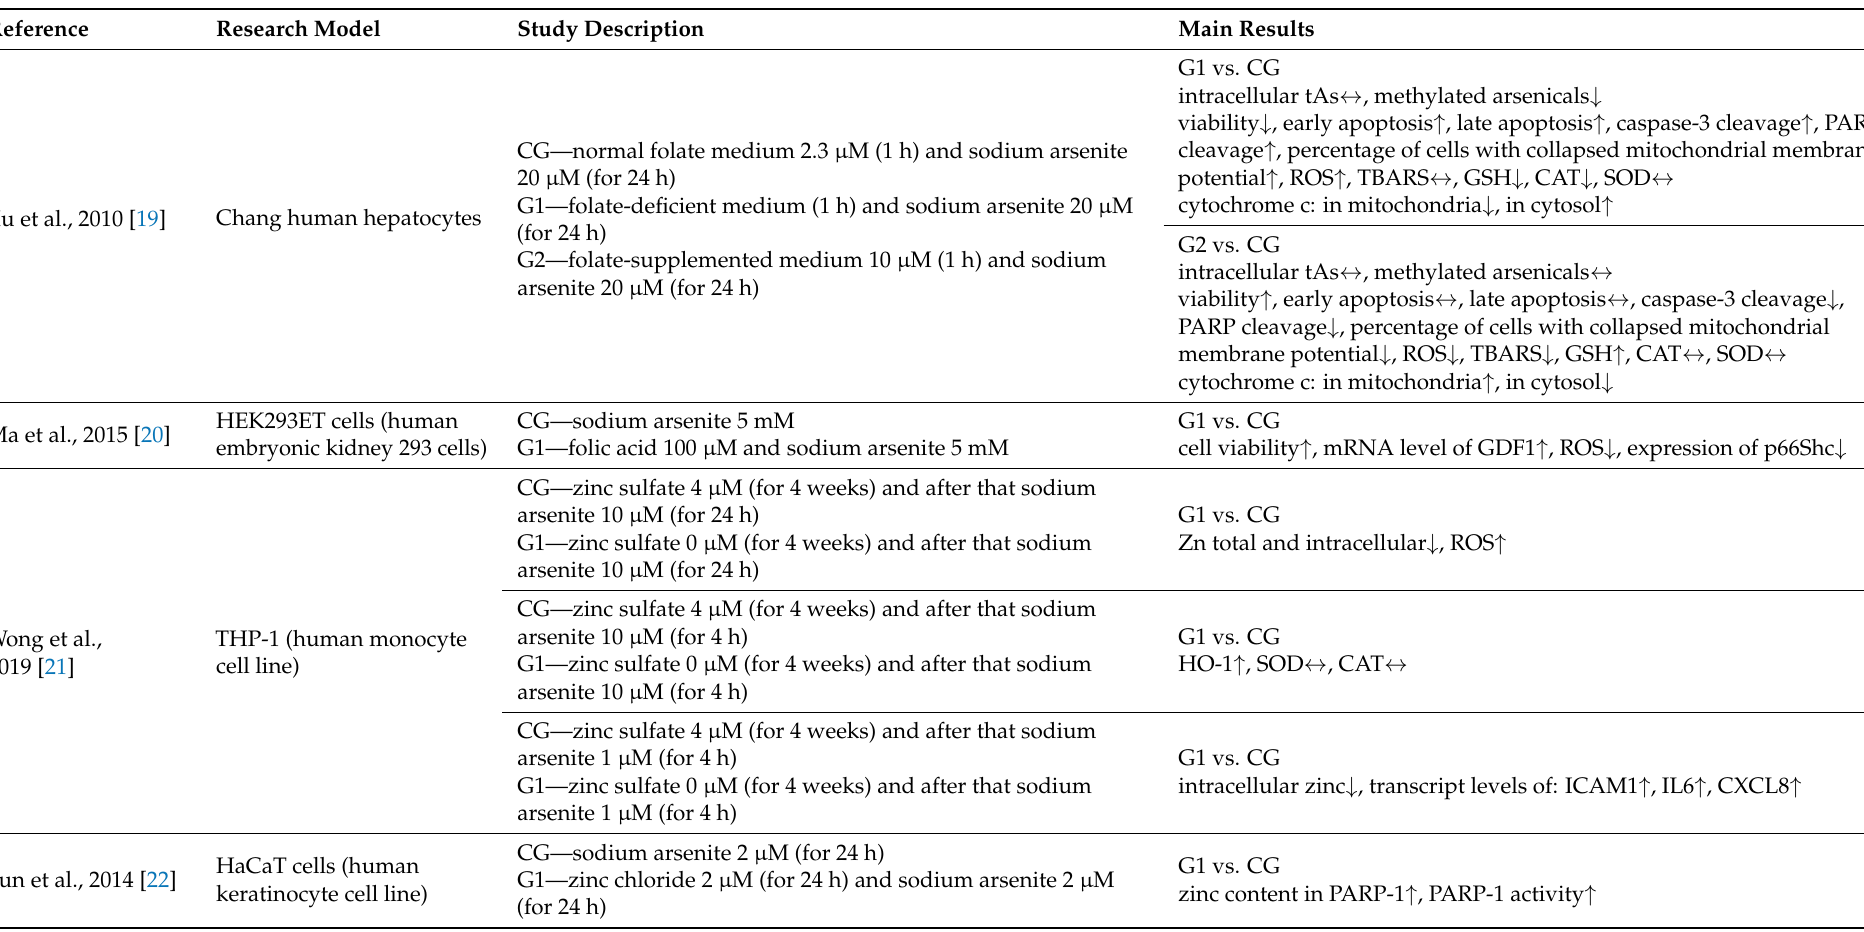
Table 1. Results of in vitro studies with iAs exposure and folic acid or zinc